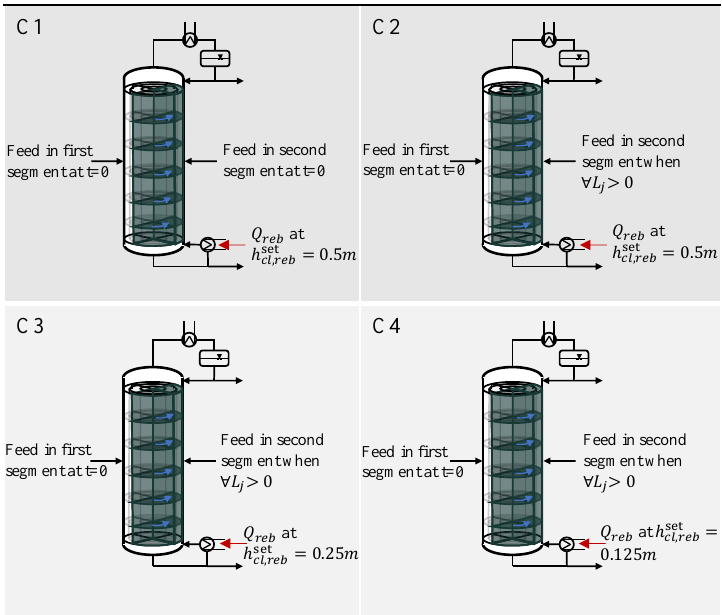
Figure 5. Assumptions for the start-up procedure of the segmented column for cases C1 – C4.